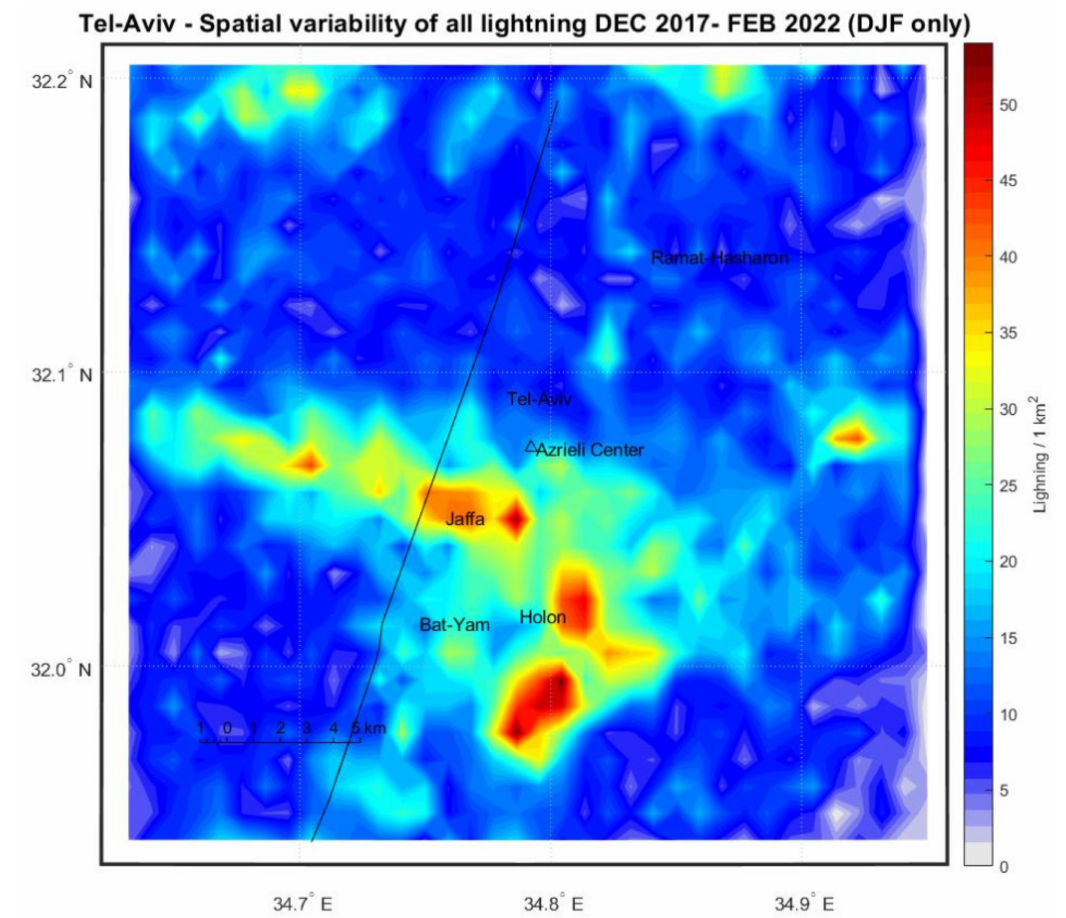
Figure 5. The spatial distribution of lightning over the study area, based on the ENTLN for the 2017/18 and 2021/22 seasons (5 winters). The Mediterranean Sea is on the left side, and several clear maxima of lightning stroke density are found south of the city center and over peripheral areas.